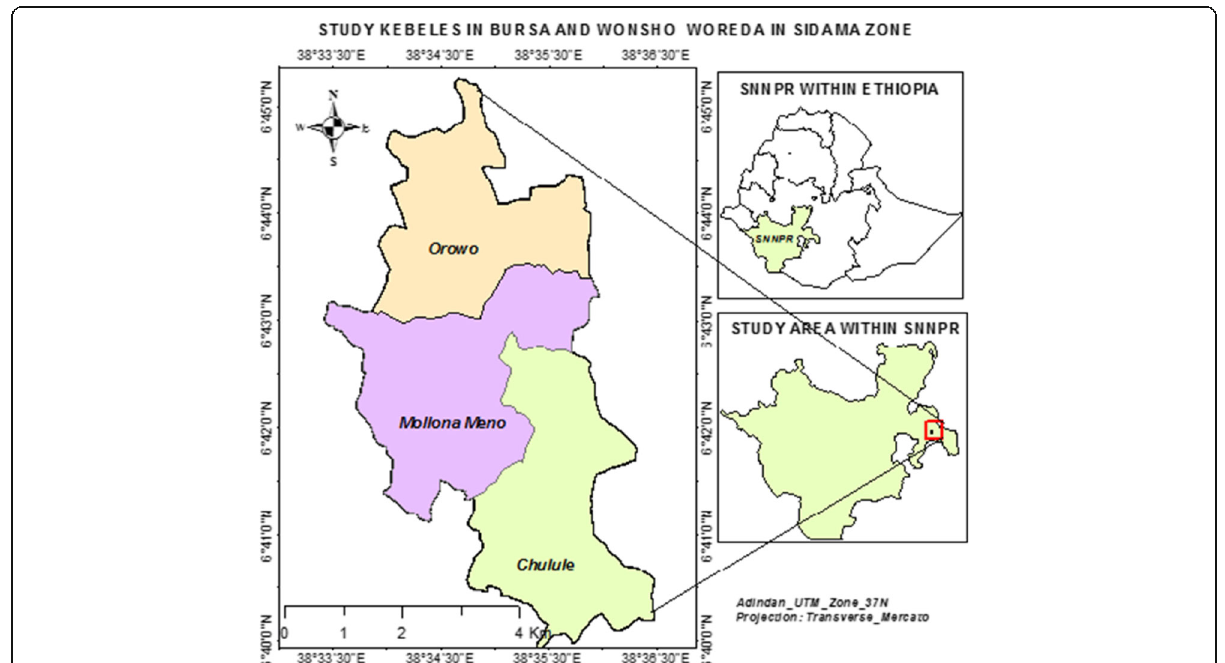
Fig. 1 Map of the study area in Sidama highland, Southern